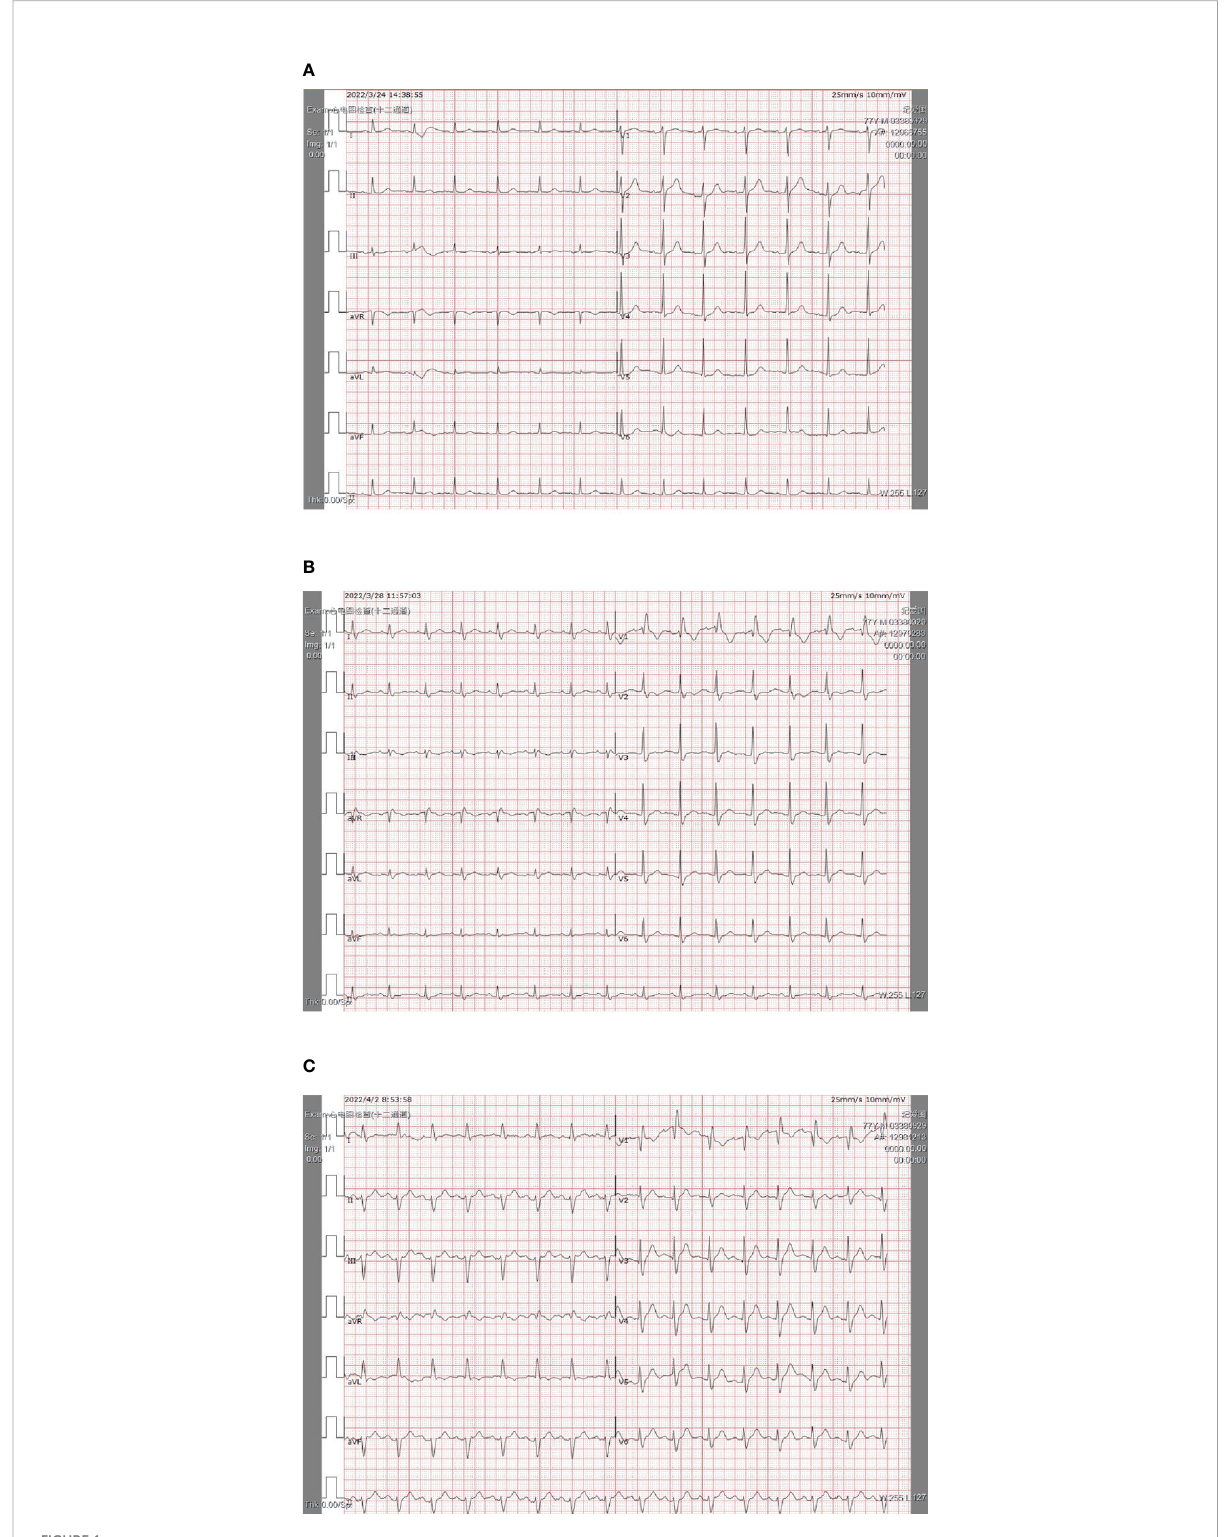
FIGURE 1 The rapid progress of the ECG of the patient ’ s within 4 days. (A) PI and II were upright; Pav was inverted. QRS widened equal to or longer than 0.12 s; V1rsR; QRS terminal in each lead was blunt and ST-T was changed secondary. (B) PI and II were upright; Pav was inverted; QRS was widened equal to or longer than 0.12 s; V1 rsR; II, III, aVF were changed to rS type; S III >S II; I, aVL leads were qR type; R avL >R I; QRS electrical axis was left biased. (C) Sinus heart rate; high atrioventricular block; abnormal Q-waves appeared in V2 – V3